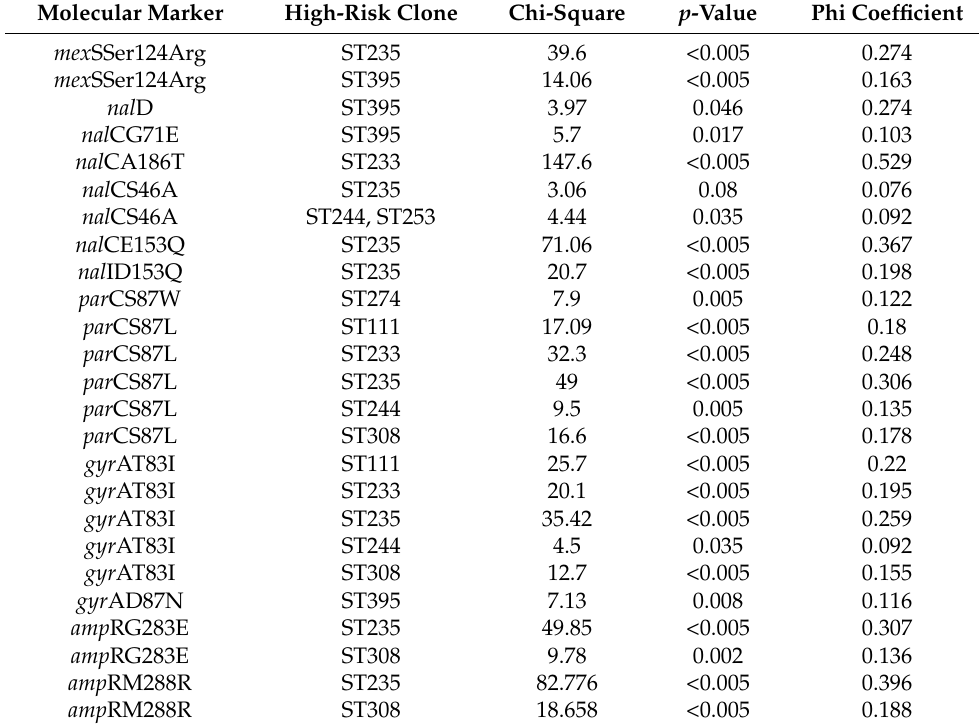
Table 2. Levofloxacin molecular markers showing significant association with specific high-risk